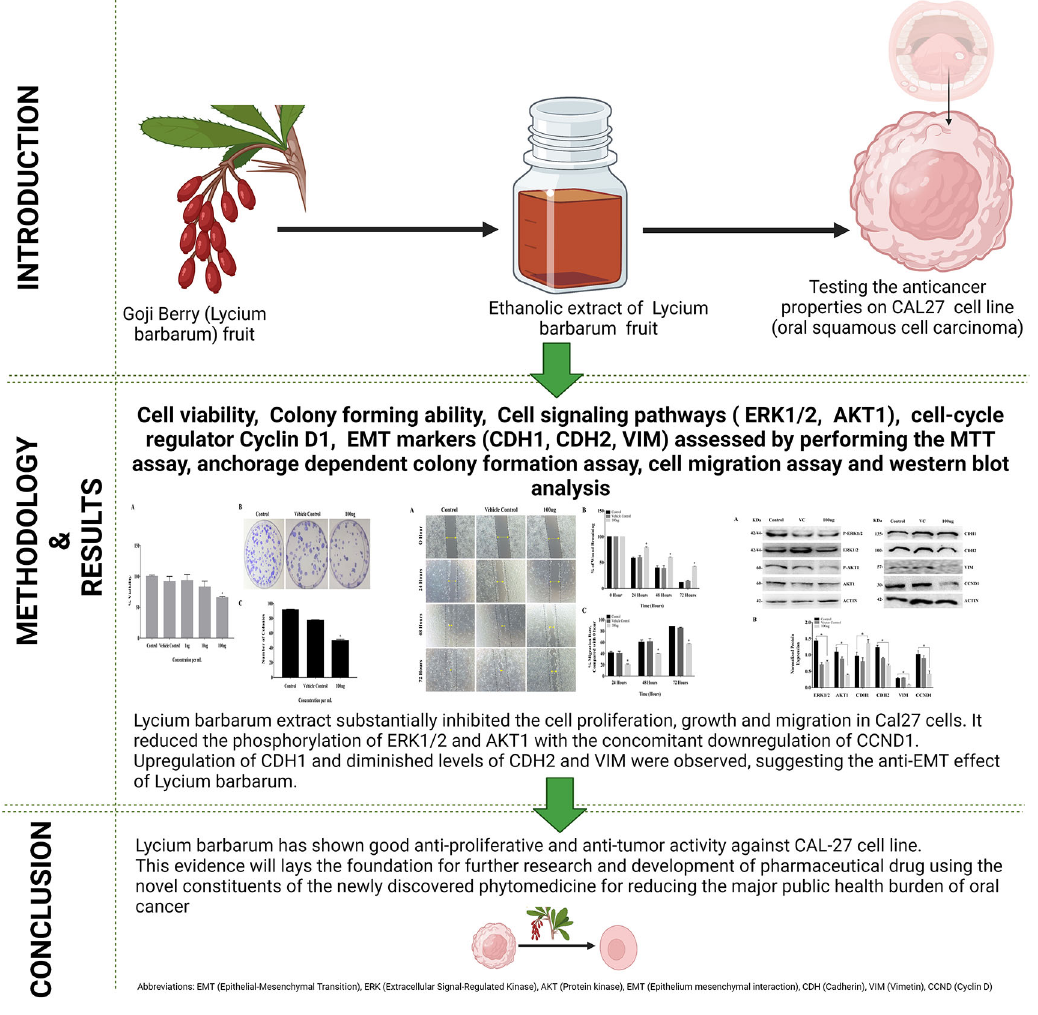
Figure 1. Schematic representation of the study design (Created in